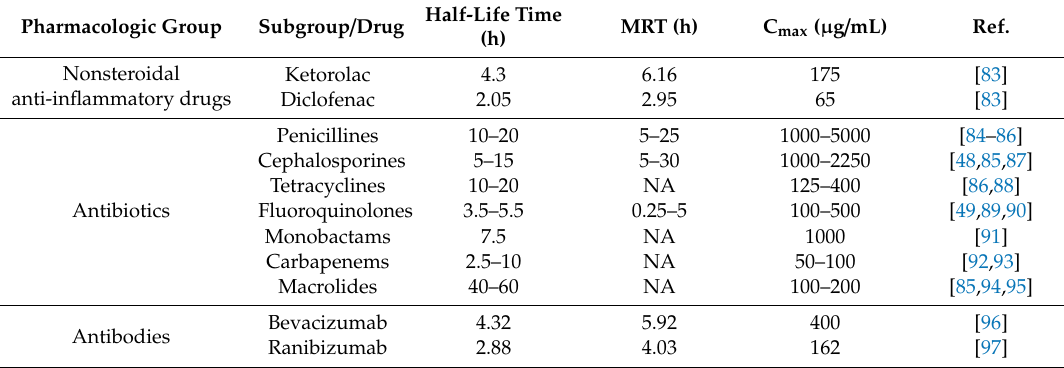
Table 3. Summary of the main key pharmacokinetic parameters for di ff erent intravitreally administered